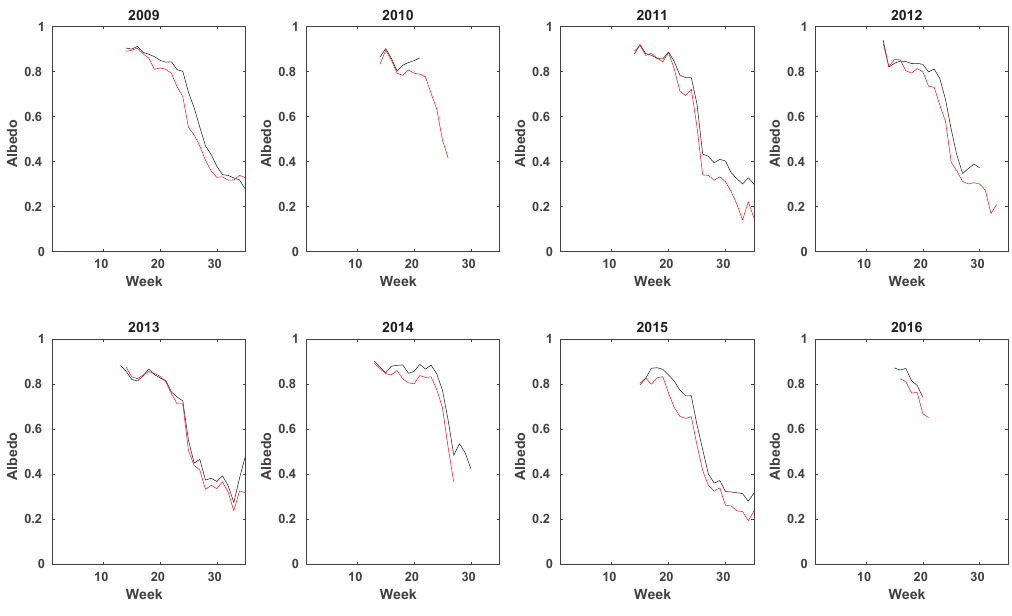
Figure 10. Mean albedo for melted ( red ) and surviving ( black ) parcels during